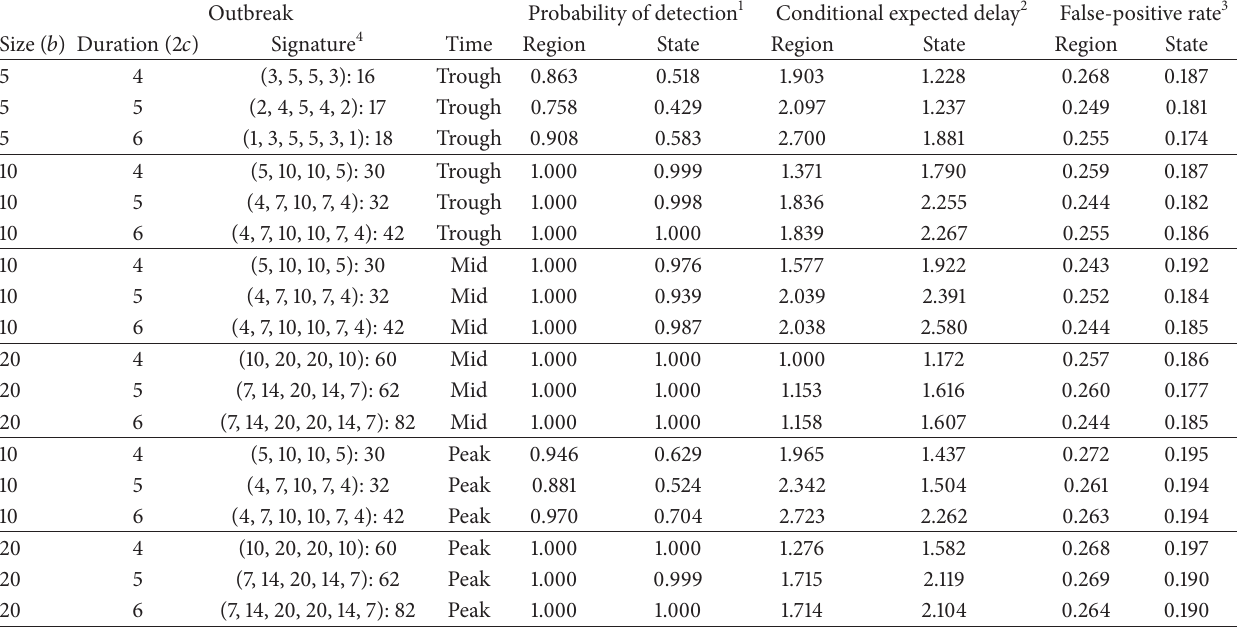
Table 3: Simulation results for pertussis outbreaks assuming outbreak model.